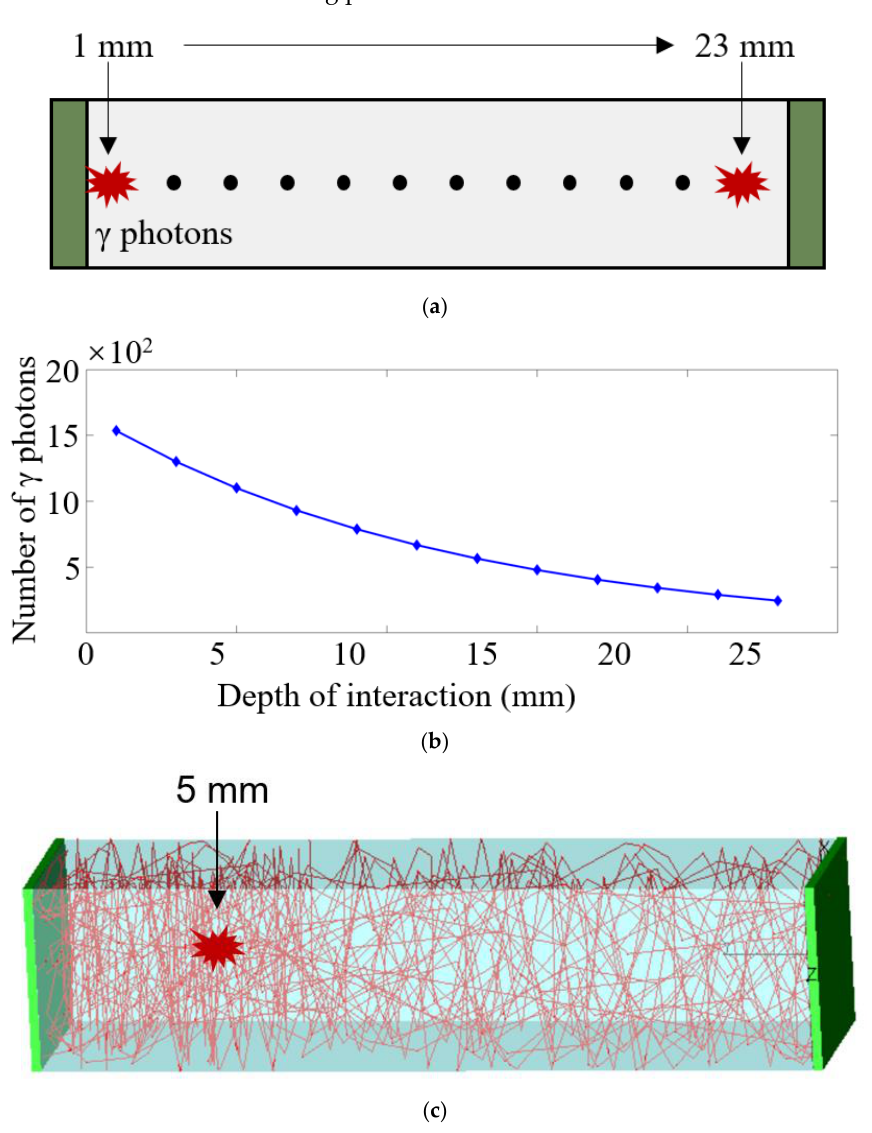
Figure 2. ( a ) The discrete interaction depth in the scintillator, ( b ) the number of γ photons generated at different depths, and ( c ) simulation model at the depth of 5 mm (only a few scintillating photons are shown in the picture).